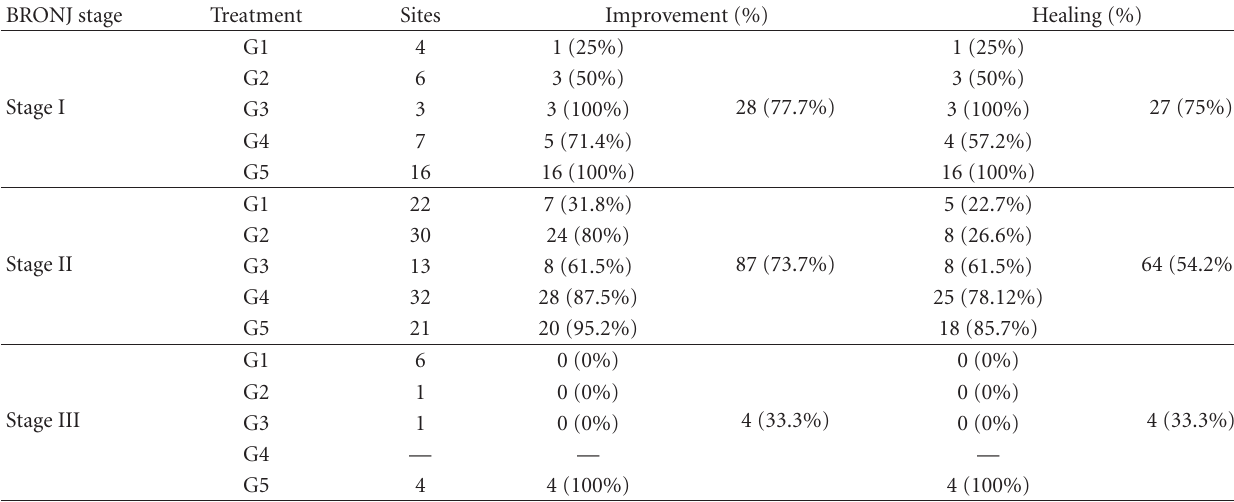
Table 7: Improvement and healing in relation with BRONJ stage independently by the primary disease. BRONJ